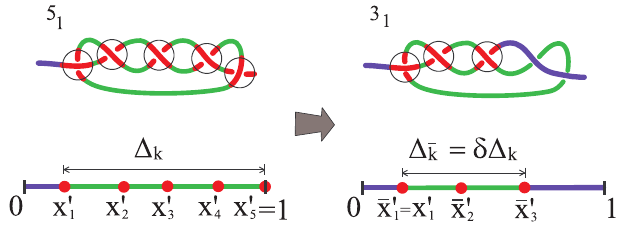
Figure 3. Simplification from a 5 1 torus knot ( left ) to a trefoil knot (3 1 ) ( right